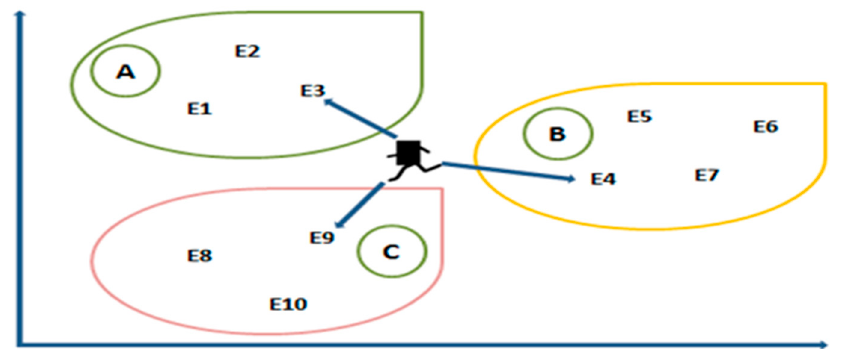
Figure 2. Illustration of how the agent checks the distance of each exit Ei inside the classes A, B, and C based on the K-Nearest Neighbor (KNN) technique and then chooses the nearest one to evacuate from.